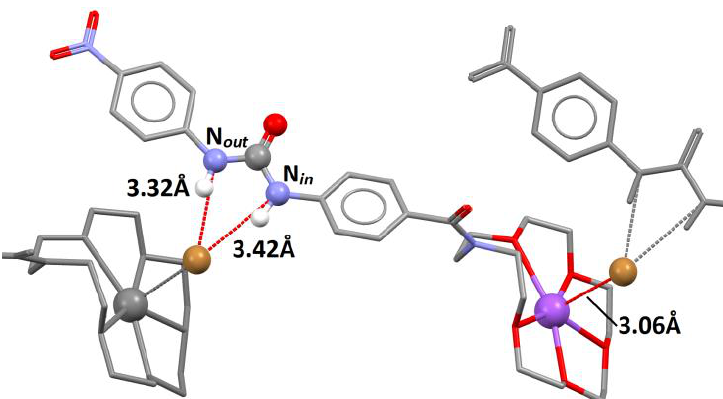
Figure 7. The crystal structure of 3 · NaBr: Urea and carbonyl groups are presented as balls; solvent molecules, most of the hydrogen atoms, and disorder were omitted for clarity; selected hydrogen bonds are presented as red lines connecting corresponding donor and acceptor groups.